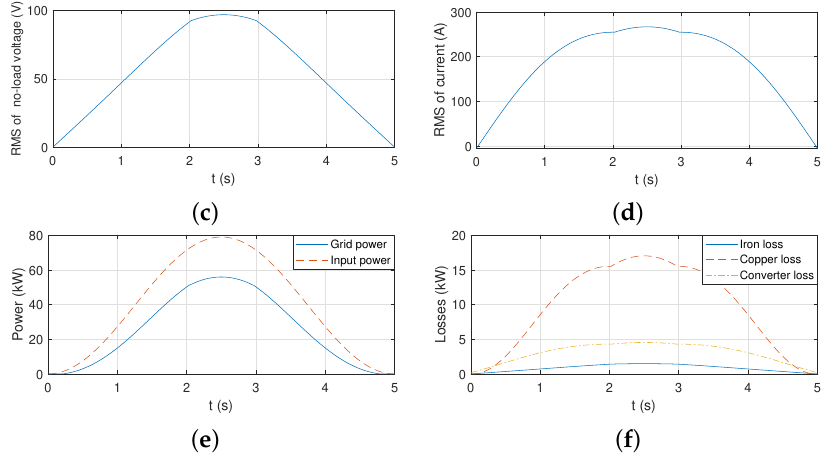
Figure 4. Generator performance over a half of wave period with a displacement of 0.85 m and a wave period of 10.0 s. The considered machine is sized with a maximum designed generator force of 200 kN based on sizing method 2. ( a ) Position and speed of the translator. ( b ) Instantaneous no-load voltage induced by the translator. ( c ) RMS value of the no-load voltage. ( d ) RMS value of the stator current. ( e ) Input mechanical power and electrical power to the grid. ( f ) Electrical losses.